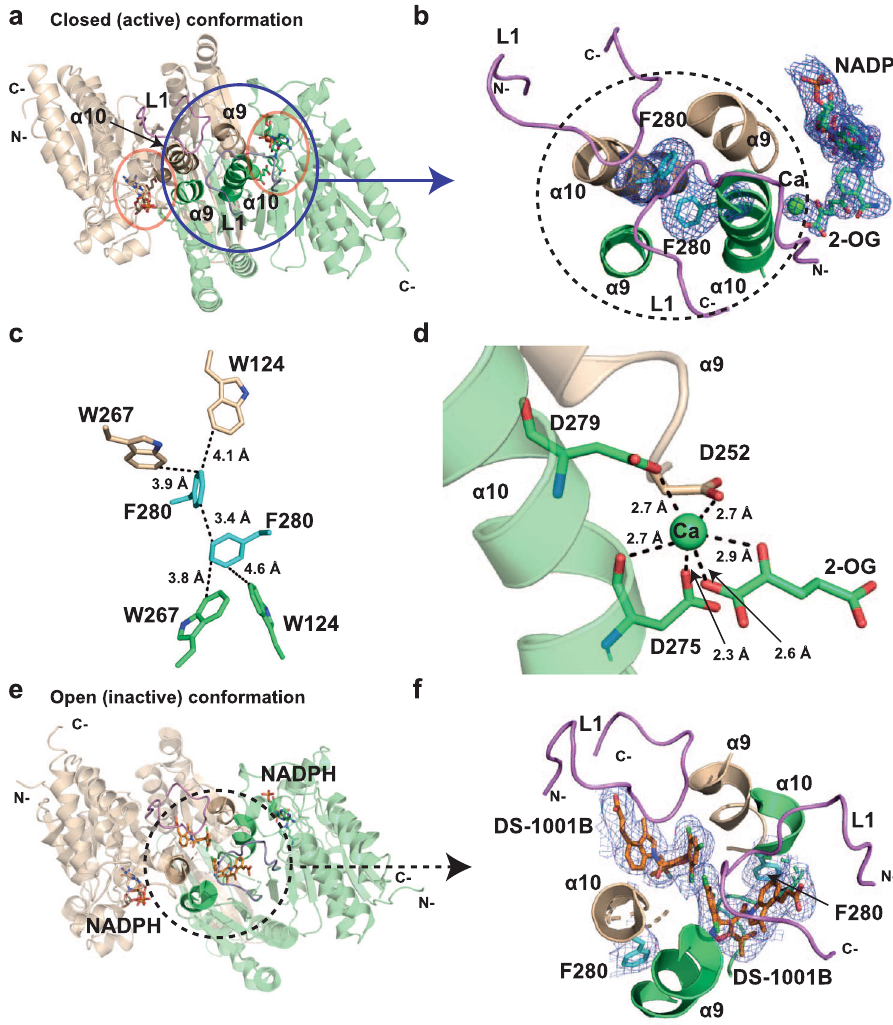
Fig.4|CrystallographicanalysesrevealthattheS280Fsubstitutionaffectsthe dimer-interface and active site of IDH1 variants. a Ribbon view from a crystal structure of R132C/S280F (PDB: 7PJM, 2.1Å resolution). As observed in the asym- metric unit, an apparent dimer is formed by chain A (wheat) and chain B (green). Orangecircles:activesiteswith2-OG,NADPH,andcalcium.L1loop:violet. b Close- up view with aPolderomit map(blue mesh, contour3.0 σ )showing 2-OG,NADPH, and calcium. The L1 loop covering the dimer-interface is in violet. Black circle: dimer-interface with a Polder omit map (blue mesh, contour: 3.0 σ ) showing F280 (cyan). c View of the dimer-interface highlighting hydrophobic interactions between W124 (L1), F280 (cyan, α 10), and W267 in both monomers. d View of the